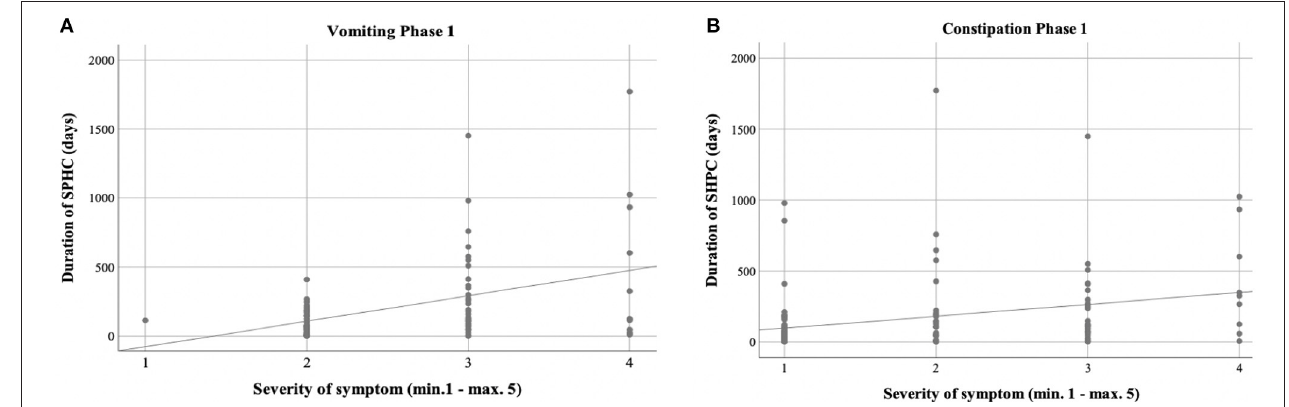
FIGURE 3 | Correlation between duration of care and severity of symptoms. (A,B) Phase 1 showed positive correlation between the duration of sickness/care vomiting (A) (|r| = 0.346; p = 0.003; Spearman) and constipation (B) (|r| = 0.388; p = 0.001; Spearman).